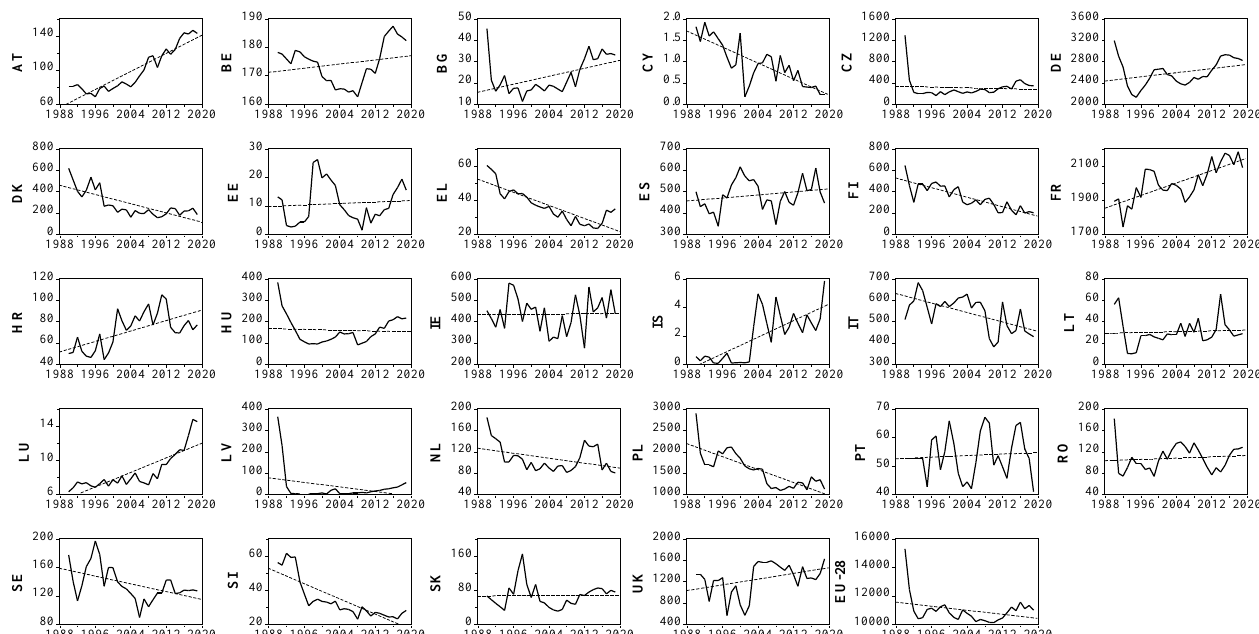
Figure 2. Time evolution of CO 2 emissions between 1990 and 2019 within EU-28 (agricultural sector).